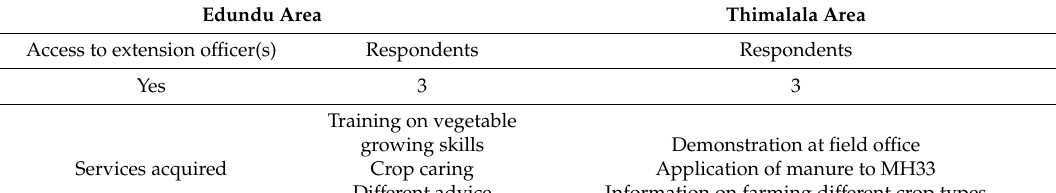
Table6. Accesstoandrankingofextensionserviceneedsbasedonrelevance(numberofresponses = 156). Information was gathered through face-to-face interviews with each farmer on the field during the PPGIS activities. Each farmer listed their priorities which were then collated and ranked according to the village area.